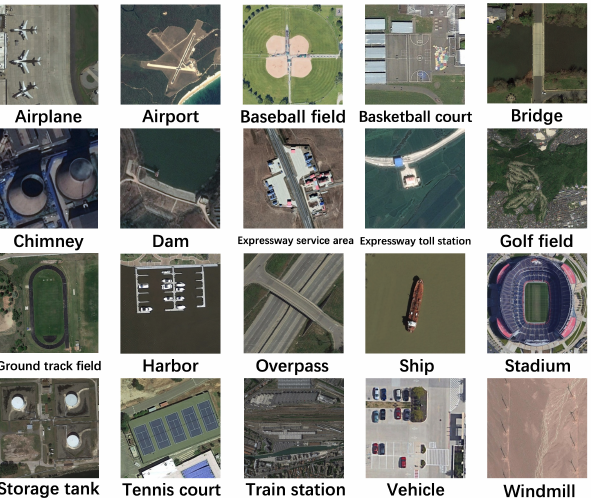
Figure 10. A set of sample images for each class in